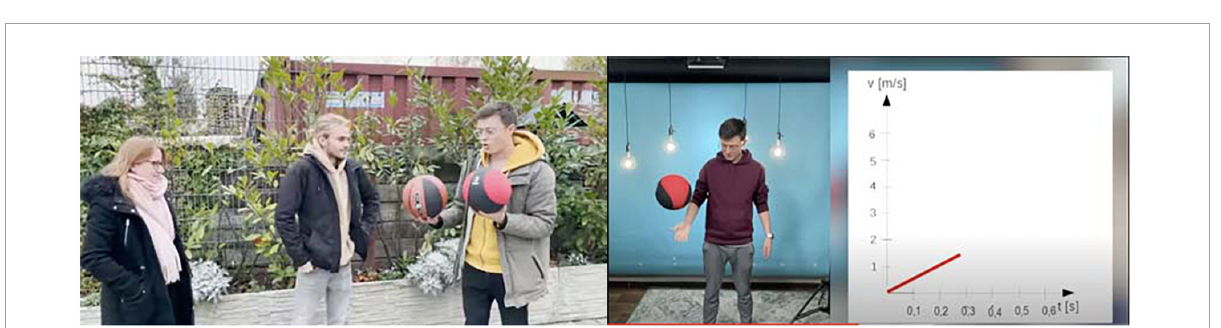
FIGURE4 Screenshots of the video: (left) interview which addressed misconceptions, (right) experiment with animation of velocity over time of a falling